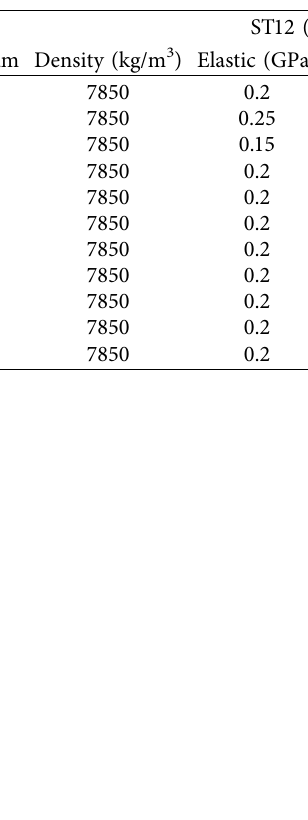
Table 1: Variable parameters examined in the analysis (continued).